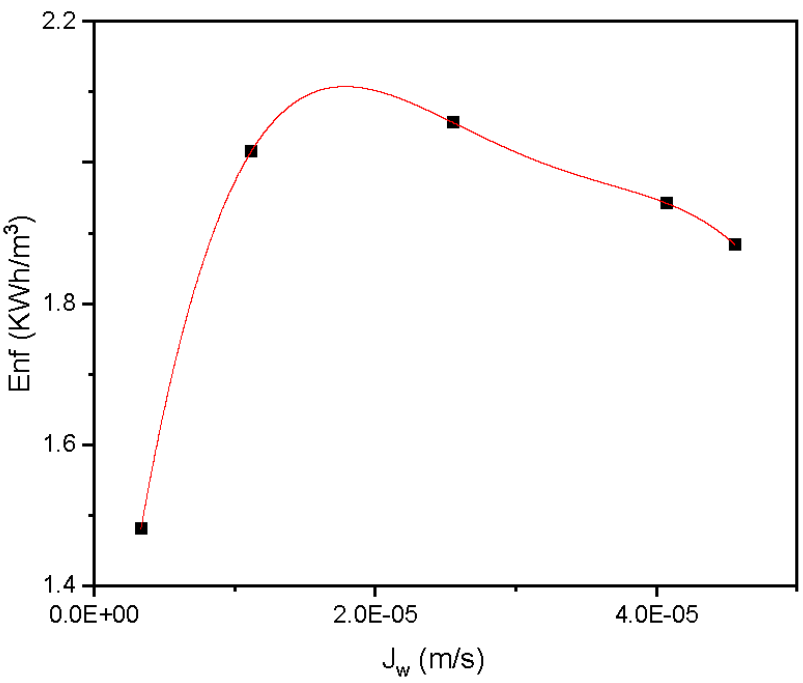
Figure 3. Variation of specific energy consumption as a function of the permeate flux.